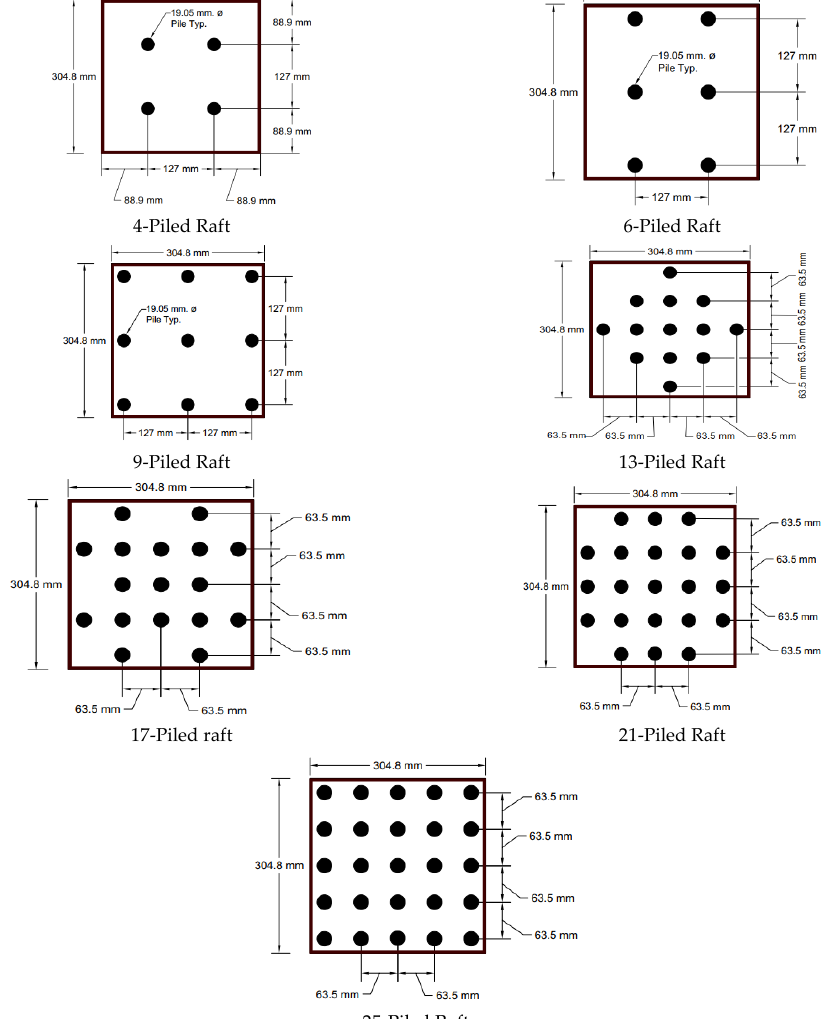
Figure 12. Plan view of piled